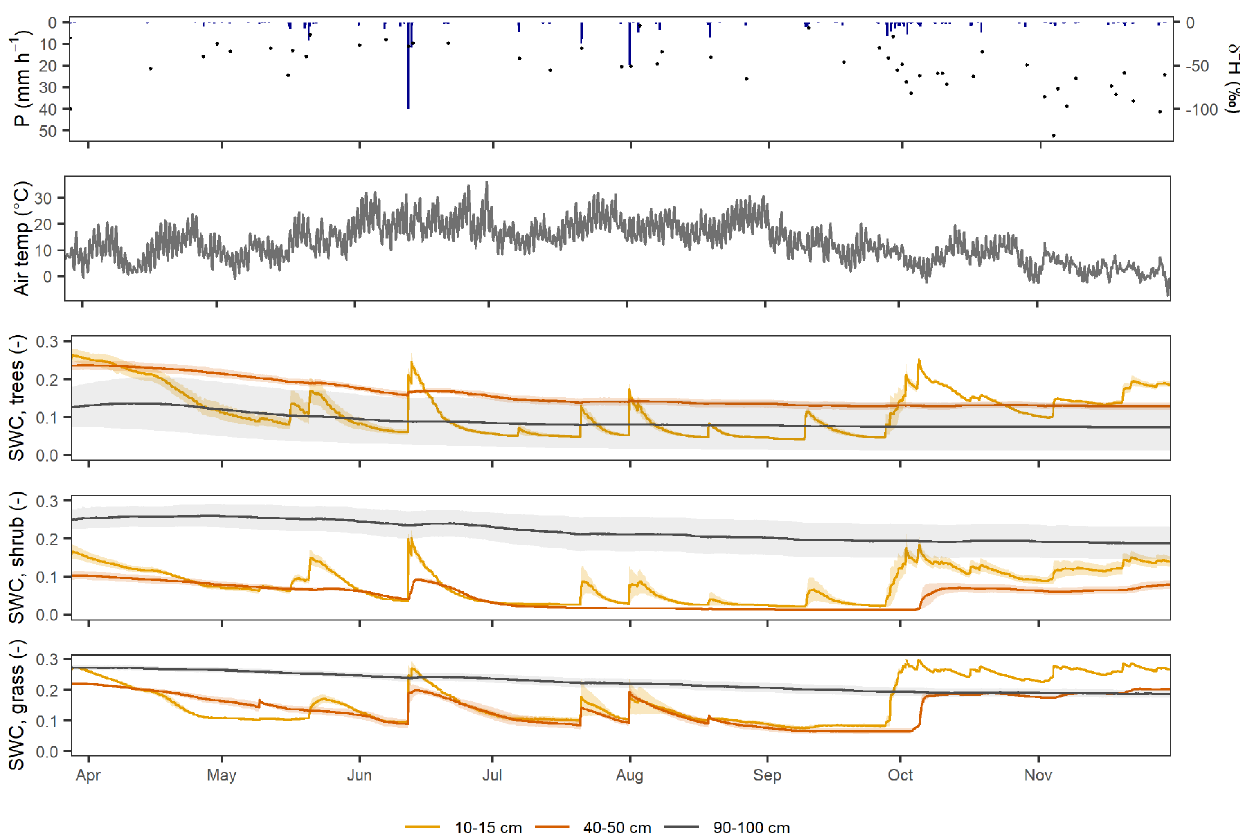
Figure 2. Precipitation, δ 2 H isotope in precipitation, air temperature at 2m and soil water content (SWC) under the three vegetation types at the SUEO from March–November 2019. All hourly values except for δ 2 H isotopes, of which samples were collected daily. The SWC values are expressed as mean (line) and range (shaded area) of the two sensors at each